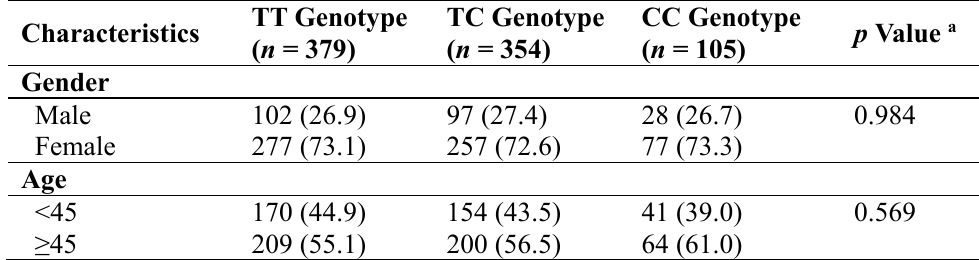
Table 3. The clinical characteristics of papillary thyroid cancer (PTC) with different rs2292832